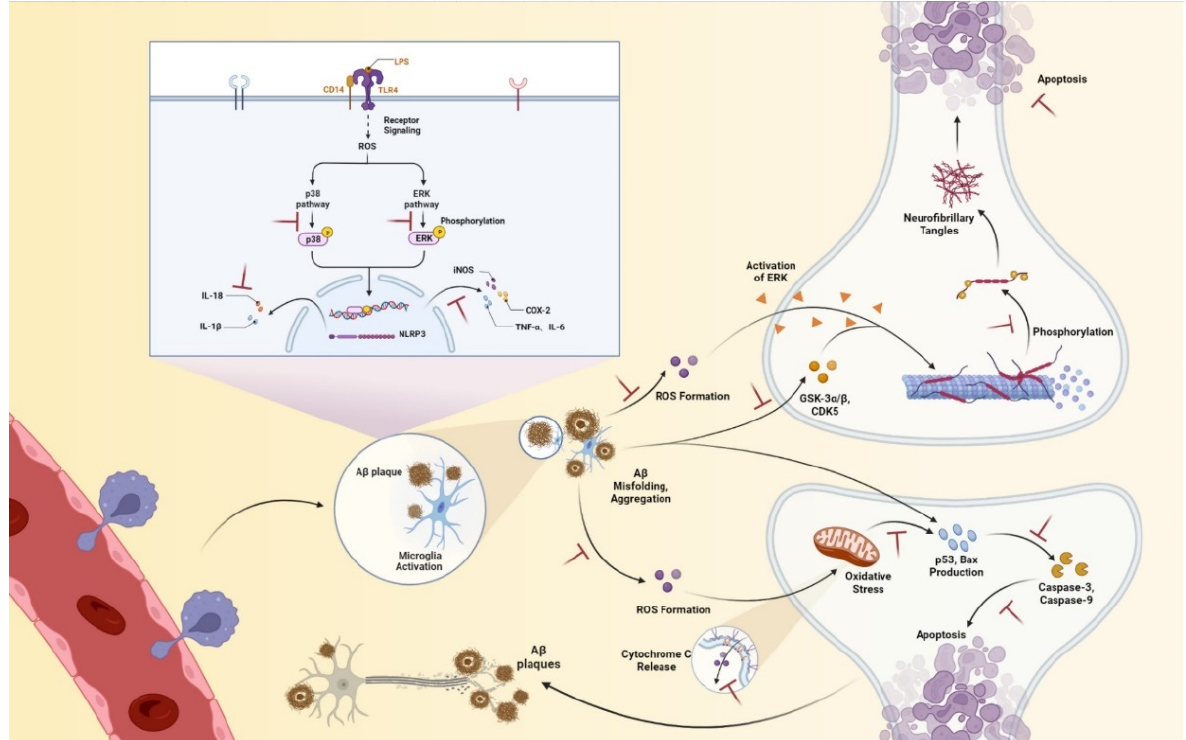
Figure 11. The mechanisms of two benzaldehydes improved neuroinflammation, and benzaldehyde 2 reduced neuronal damage. Benzaldehydes 1 – 2 reduced the LPS-induced neuroinflammation via feasible signaling mechanisms. They also inhibited the protein level expression of iNOS and COX-2, the release of TNF- α , IL-6, IL-18, and levels of phosphorylated ERK and p38. Benzal- dehyde 2 down-regulated the A β -stimulated neuronal damage via caspase family-related path- ways. In addition, it inhibited the protein level expression of CDK5 and GSK-3 α / β , and reduced phosphorylation of Tau. Benzaldehyde 2 also reduced the release of ROS and further alleviated the decrease in mitochondrial membrane potential, with less cytochrome C flowing out.